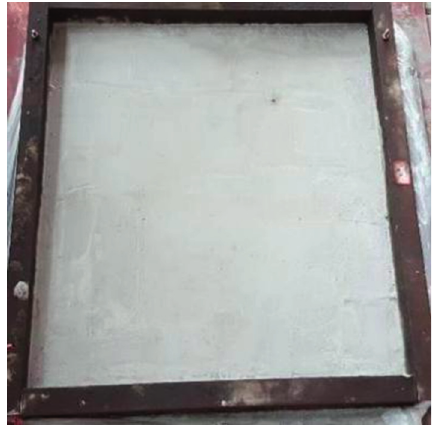
Figure 13: Test A1.